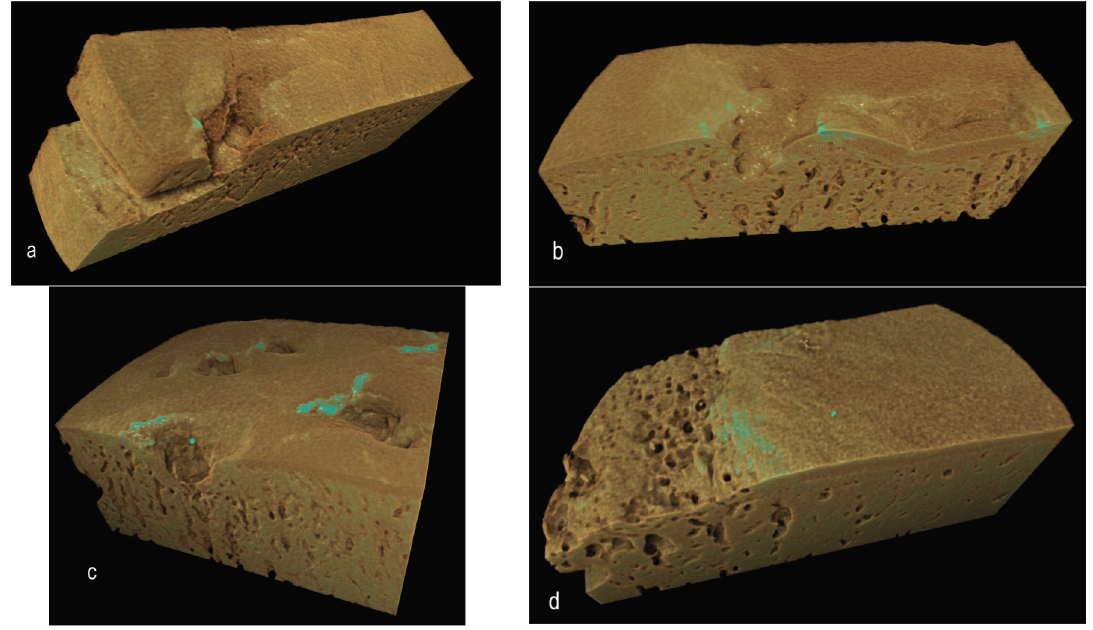
Figure 4. Drishti renderings showing high-density regions within or at the ACC MF surface, the denser regions tinged blue: ( a ) Two-year-old, left side, early OA in more palmar site; ( b ) Same bone, the more dorsal site, early OA; ( c ) Same horse, right limb, more dorsal site, advanced OA; and ( d ) Four-year-old, more dorsal site, advanced